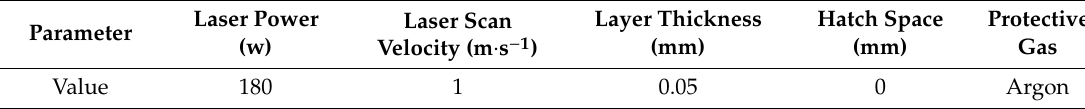
Table 1. Process parameters used in this study.